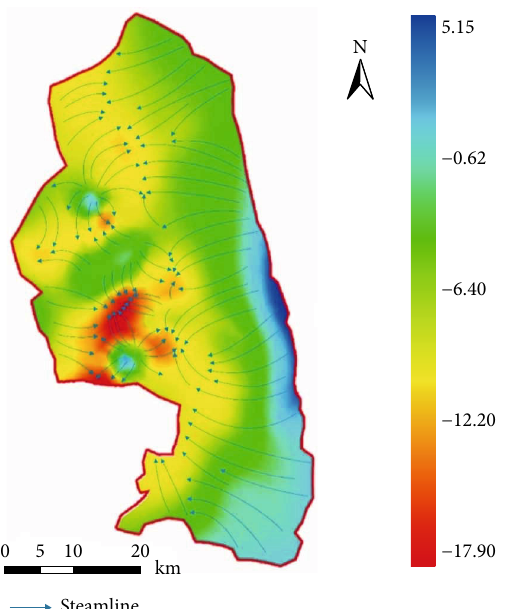
Figure 8: The visualization results of porous groundwater seepage fl ow fi eld based on vector line